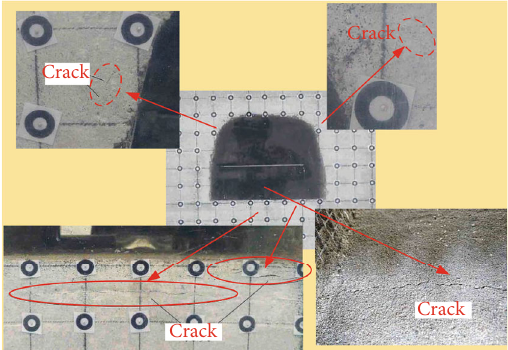
Figure 5: Cracks in the surrounding rock of the roadway.